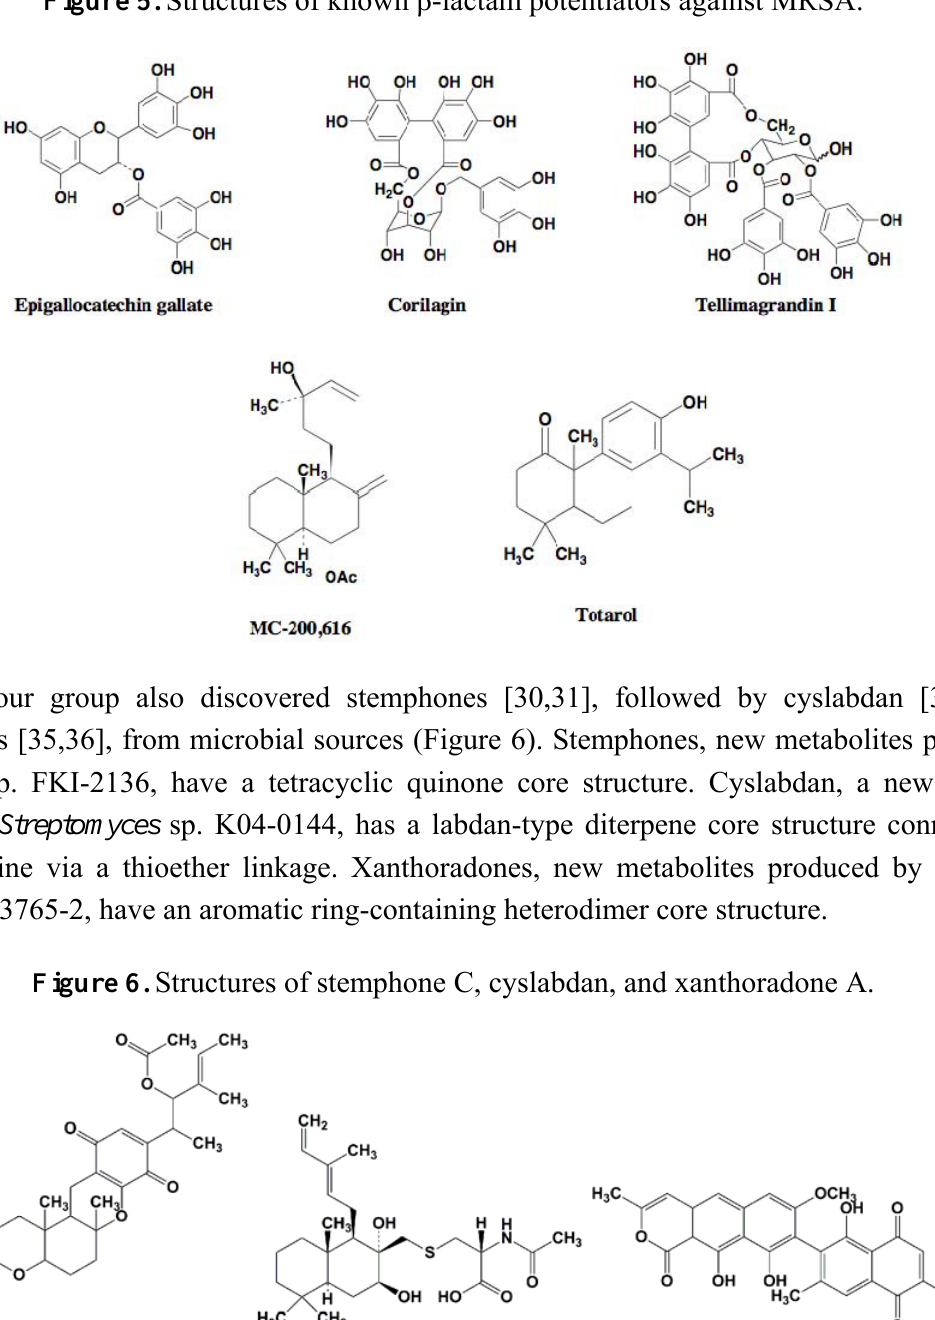
Figure 5. Structures of known β -lactam potentiators against MRSA.